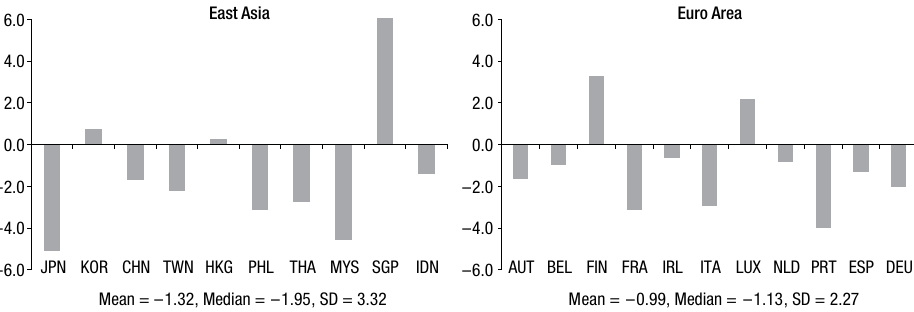
Fig. 9. General government budget balance (% of GDP), 1999–2009 Source : ADB and Eurostat databases